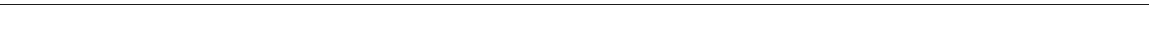
Fig. 2 Mutation of RRP-8 impairs rRNA methylation and processing. a Schematic diagram of ribosome biogenesis in yeast and mammals. RRP8 may be involved in pre-rRNA cleavage and methylation. b Top panel: alignment of partial amino acid sequences of RRP-8 across several organisms, including Homo sapiens (NP_056139.1), Macaca mulatta (AFH30501.1), Bos taurus (NP_001179303.1), and Danio rerio (XP_017206635); the conserved glycine is marked by an asterisk. Bottom panel: schematic diagram of the mutation (G301R) in the methyltransferase-like domain (MLD) of RRP-8 and the mutation site is indicated by an asterisk. c The m1A modi fi cation site of 25/26S rRNA in yeast and C . elegans . d The rRNA methylation rate at the indicated site (A674) in 26S rRNA. e Schematic diagram of the pre-rRNA (a) and its processed intermediates (b, b1, c, and c1) in C . elegans 14, 22 . The cleavage sites (0 – VIII) are indicated in the pre-rRNA. The underlined “ _ ” under 0 – VIII represents QPCR regions for detection of the splicing ef fi ciency. The positions of probes 1 – 3 used for northern blot analysis are shown in the indicated regions (red “ _ ” ). f , g Detection of Pre-rRNA levels ( f ) and splicing ef fi ciency of probable cleavage sites in pre-rRNA ( g ) by RT-qPCR. The levels of rRNA at each indicated site (0 – VIII) were detected in 1-day-old WT and rrp-8 ( kun54 ) worms by RT-qPCR with the corresponding primers listed in the corresponding method. Data are presented as the mean 2 − ddCt ± SD of four biological replicates using tbb-2 as a reference gene. h Northern blot analysis of pre-rRNA and its processed intermediates in WT and rrp-8 ( kun54 ) worms. Equal amounts of total RNA (5 μ g) were loaded on a 1.2% denaturing formaldehyde/agarose gel and analyzed by northern blotting with digoxin-labeled probes 1 – 3 indicated in e . tbb-2 was used as a control of RNA quality. Data are presented as the mean ± SD of four biological repeats. Signi fi cant difference between WT and the rrp-8 ( kun54 ) mutant, Student ’ s t -test, ** P < 0.01, * P < 0.05. NS, no signi fi cant